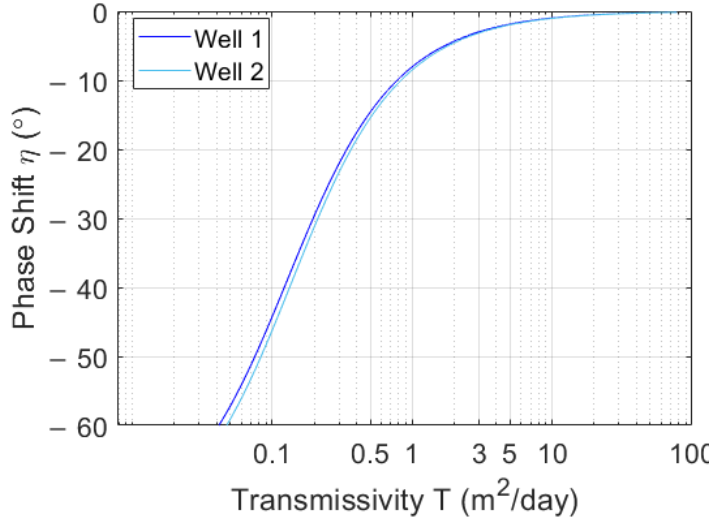
Figure 3. Relation between phase shift η and transmissivity T estimated for parameters of the wells.